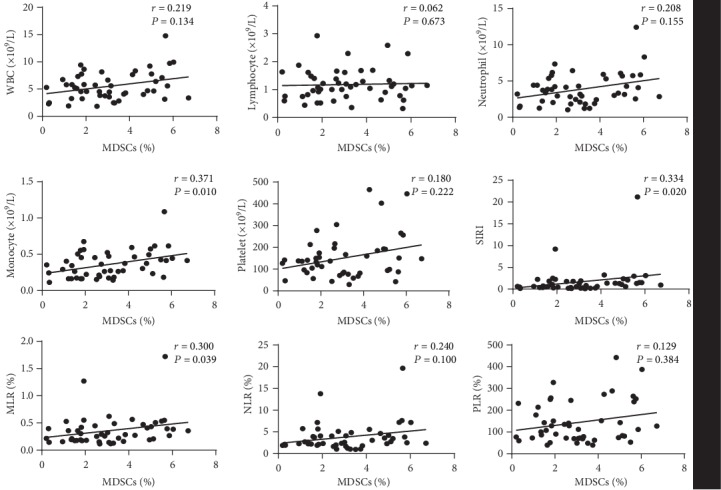
Correlations between the percentages of circulating MDSCs and levels of system inflammation parameters. Levels of system inflammation parameters including the counts of WBC, lymphocyte, neutrophil, monocyte, and platelet, as well as systemic inflammation response index (SIRI), monocyte/lymphocyte (MLR), neutrophil/lymphocyte (NLR), and platelet/lymphocyte (PLR).